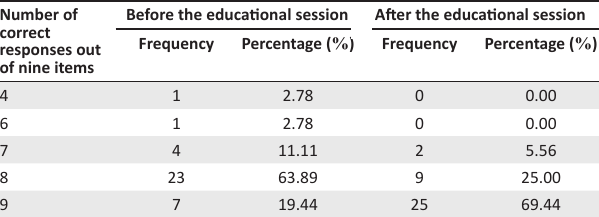
TABLE 1: Demographic characteristics of the participants.